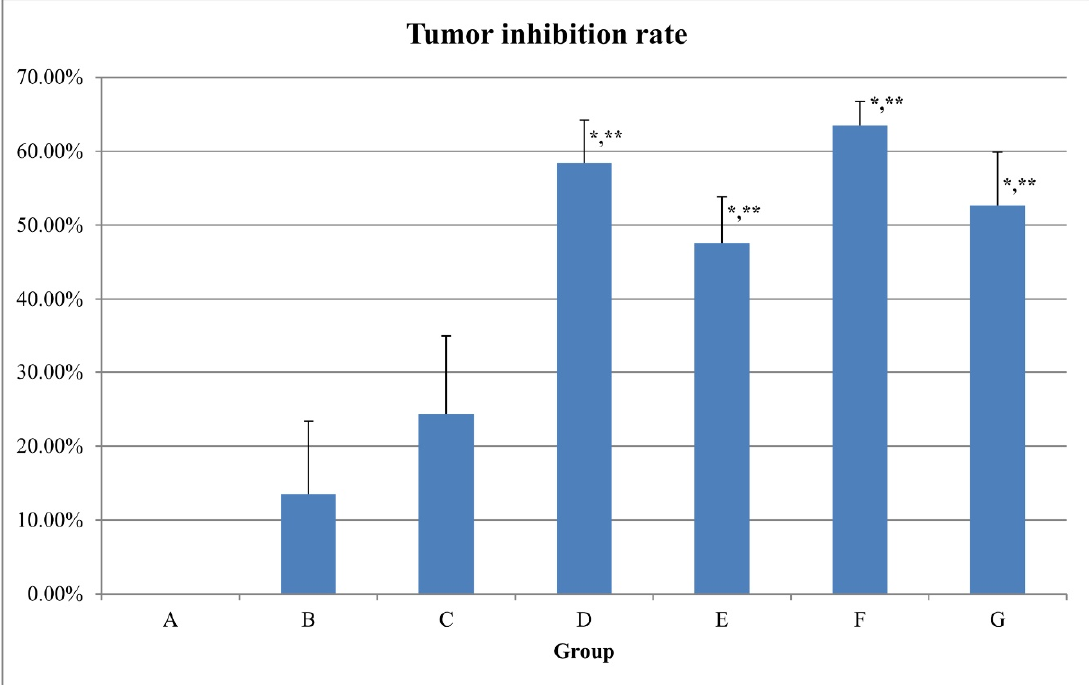
Figure 5. The tumor inhibition rate of the liposomes. A, 5% glucose; B, blank liposome; C, taxol injection 10 mg/kg; D, cabazitaxel injection 2.5 mg/kg; E, β -elemene liposome 25 mg/kg; F, cabazitaxel liposome 2.5 mg/kg; G, cabazitaxel- β -elemene complex liposome 0.625 mg/kg after the first 2.5 mg/kg. *Compared with the 5% glucose group, there was a statistically significant difference ( p < 0.01). Compared with the 5% glucose group, the statistics parameter of the cabazitaxel injection group was t = − 11.870, p < 0.01; that of the β -elemene liposome group was t = − 10.095, p < 0.01; that of the cabazitaxel liposome was t = − 15.615, p < 0.01; and that of the cabazitaxel- β -elemene complex liposome was t = − 11.824, p < 0.01. **Compared with the taxol injection group, there was a statistically significant difference ( p < 0.01). Compared with the taxol injection group, the statistics parameter of the cabazitaxel injection was t = − 8.294, p < 0.01; that of the β -elemene liposome group was t = − 5.648, p < 0.01; that of the cabazitaxel liposome was t = − 10.461, p < 0.01; that of the cabazitaxel- β -elemene complex liposome was t = − 7.091, p < 0.01. Compared with the cabazitaxel injection group, the statistics parameter of the cabazitaxel- β -elemene complex liposome group was t = 1.842, p > 0.05, there was no statistically significant difference. Compared with the β -elemene liposome group, the statistics parameter of the cabazitaxel- β -elemene complex liposome group was t = − 1.669, p > 0.05, there was no statistically significant difference. The tumor inhibition rates of group B, C, D, E, F, G were 13.53% ± 9.81%, 24.33% ± 10.67%, 58.40% ± 5.81%, 47.62% ± 6.25%, 63.46% ± 3.27%, and 52.71% ± 7.18%, respectively.